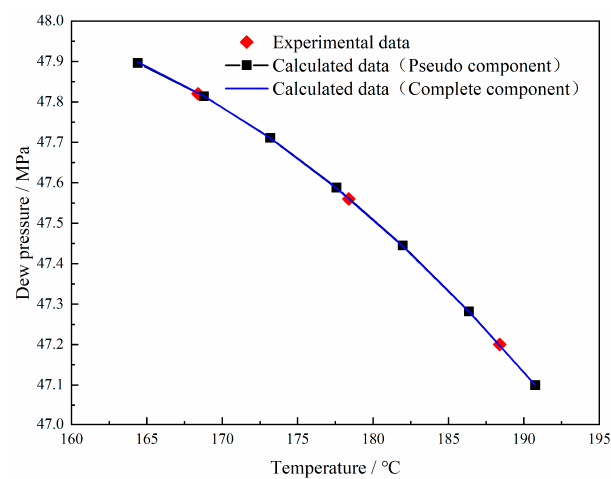
Figure 4. Dew pressure fitting diagram.